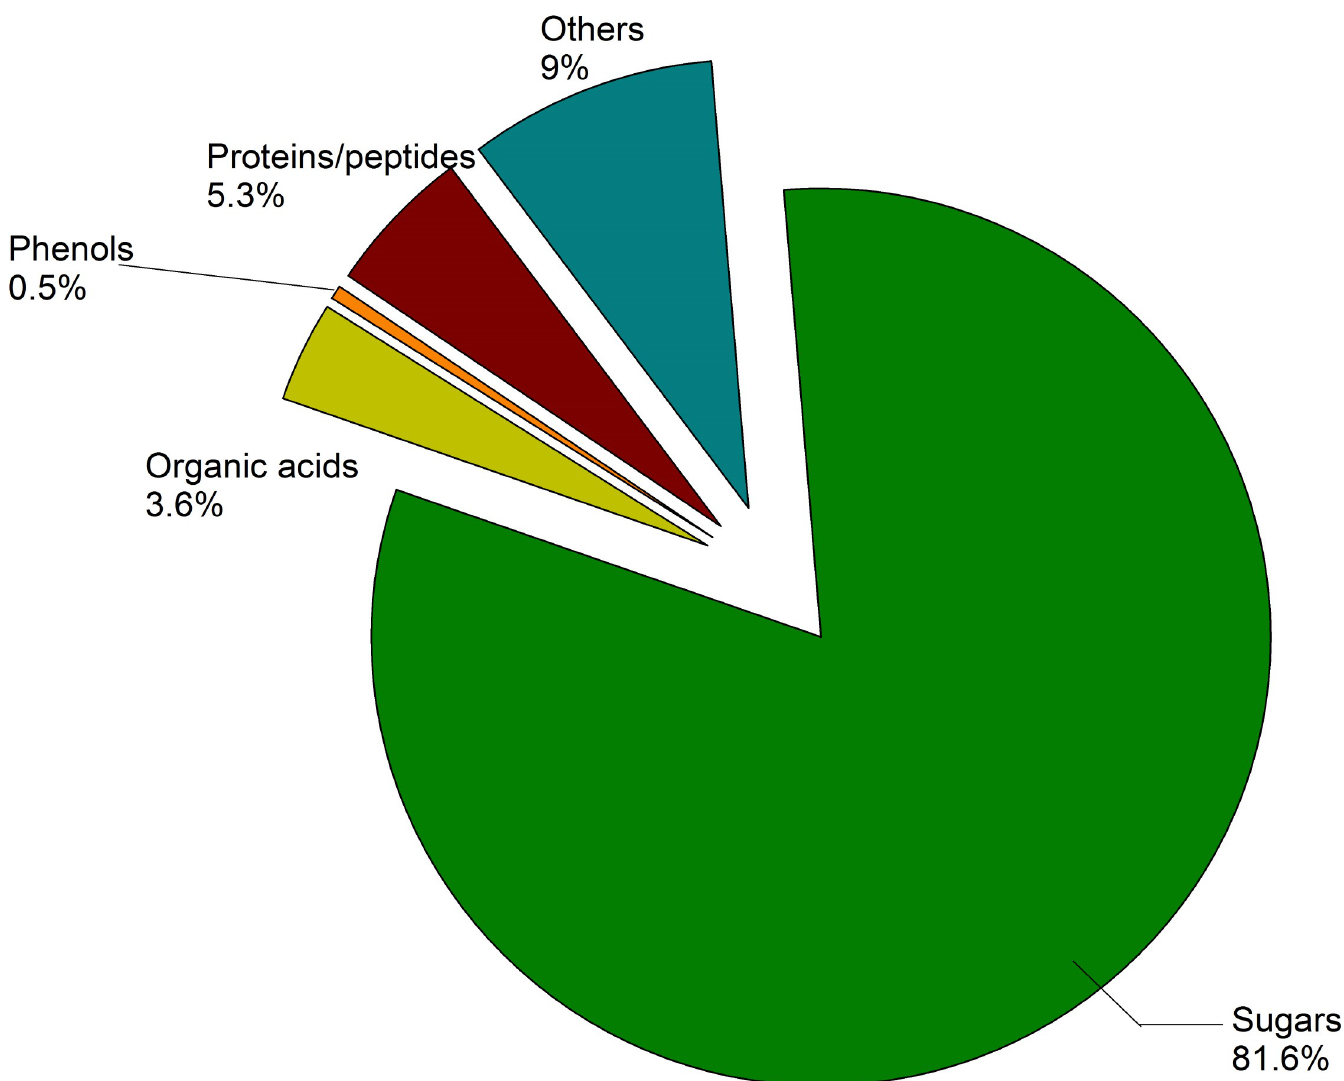
Fig 1. Contribution to chemical oxygen demand (COD) by constituents of cabbage wash